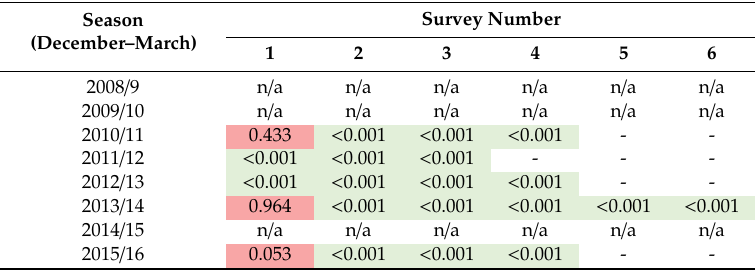
Table A3. Summary of p -values when comparing SF-NAO and SF-WEPA shoreline forecasts. Green shading highlights p -values < 0.001, with pink shading for p -values ≥